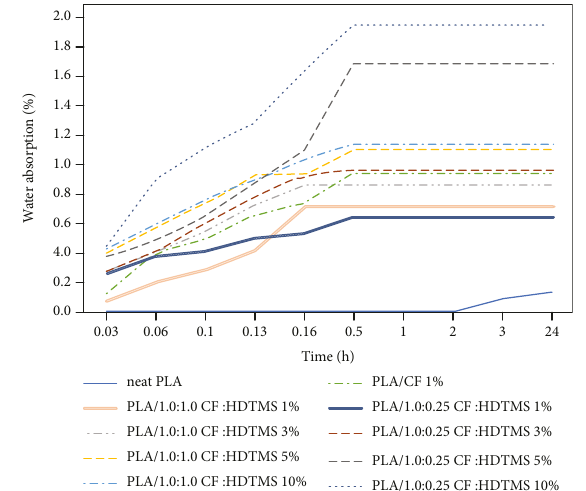
Figure 5: Percent water absorption of neat PLA and PLA/ hydrophobic CF/SiO composites. 2